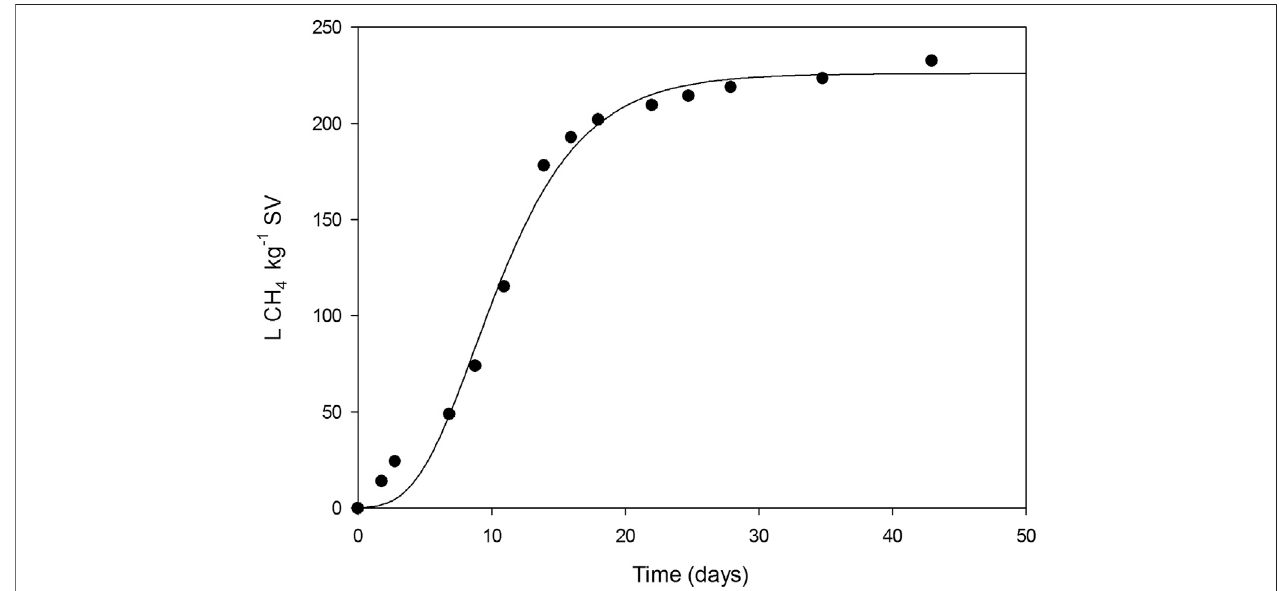
FIGURE 6 | Methane potential production for spent fermented solids and adjustment of Gompertz model.